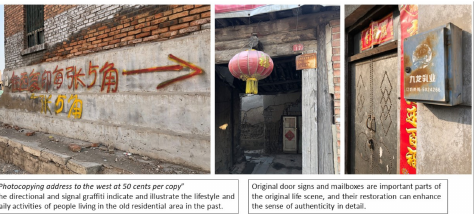
Figure 14. Details relating to the old living activities are essential in creating the authentic urban scene. Source: